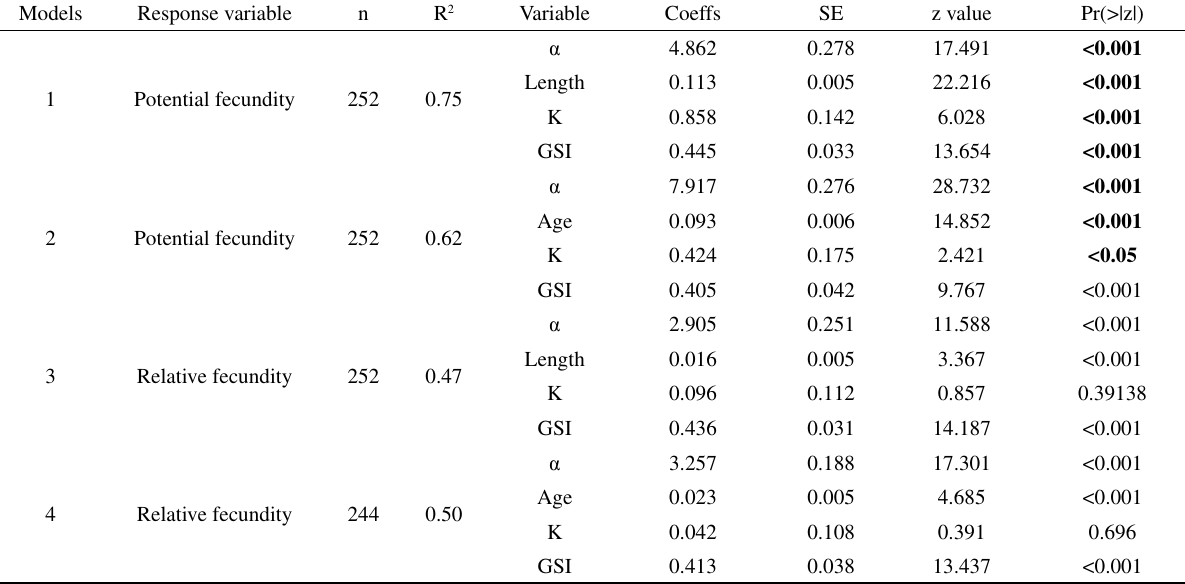
Table 2. – Summary of GLM negative binomial models fitted to estimate the effect on potential and relative fecundity of the maternal traits fork length, age, condition factor (K) and gonadosomatic index (GSI) of S. fasciatus on the Flemish Cap.